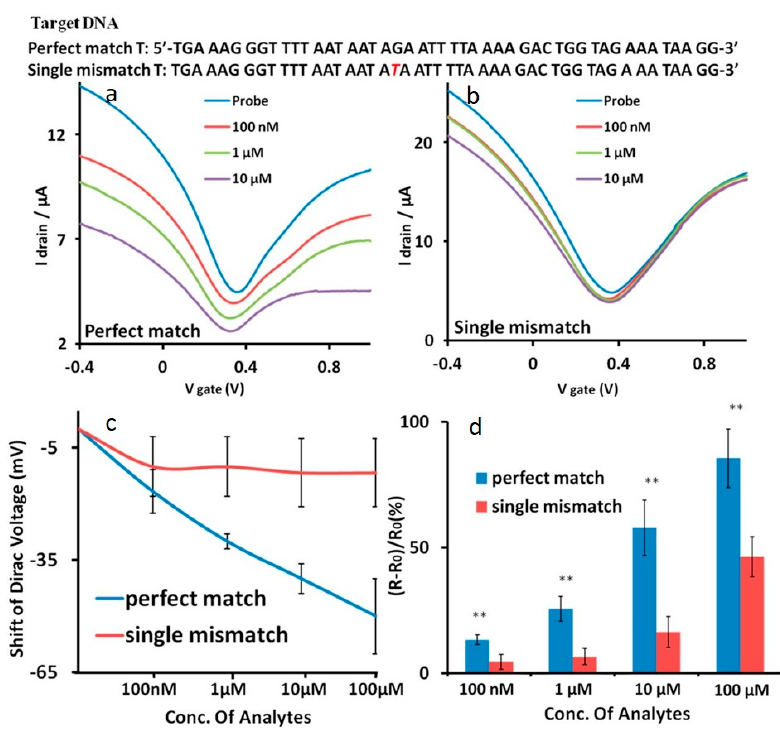
Figure 4. Transfer curves for a G-FET produced by Hwang et al. for each stage of the strand displacement sensing process for ( a ) perfect match DNA and ( b ) single nucleotide polymorphism (SNP) DNA. ( c ) V D shift for perfect match and SNP DNA at various concentrations showing the clear discrimination between perfectly matched DNA and DNA containing an SNP. ( d ) Quantitative measurement of both the perfectly matched DNA and DNA containing an SNP using resistance changes across the graphene channel. For the data highlighted here ** p < 0.01 based on three sets of independent data points. Reprinted from [38].